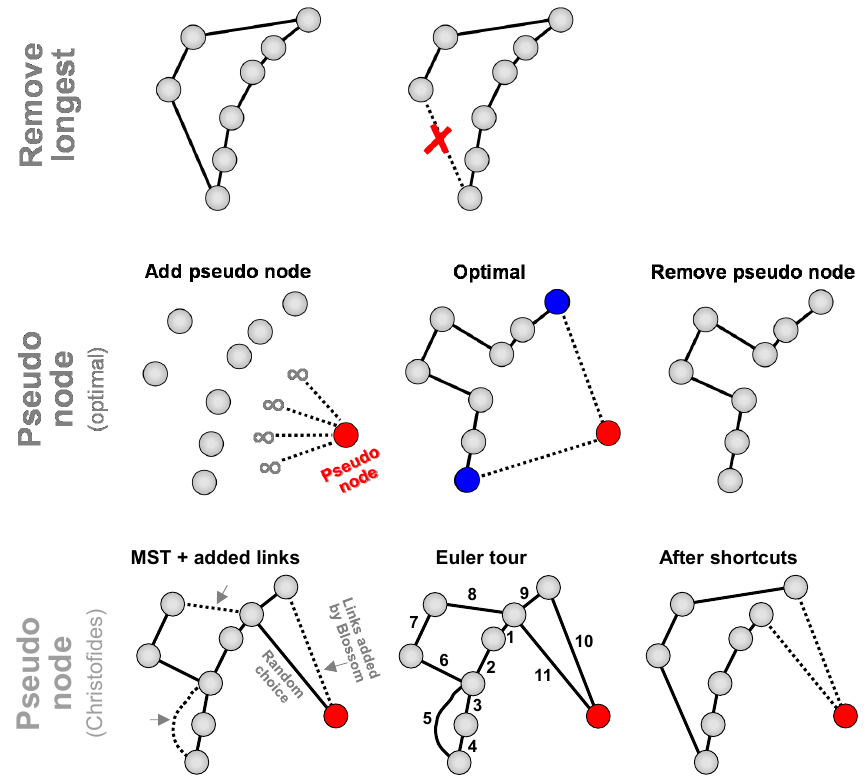
Figure 7. Two strategies for applying closed-loop algorithms for the open-loop cases. First strategy (top) simply removes the longest link, but this does not guarantee optimality even if the closed-loop solution is optimal. Second strategy adds pseudo node with equal distance to all other nodes. The consequence is that there are two long links connected to the pseudo node that can be omitted from the closed-loop solution. This does not affect the optimization at all due to the equal weights. The nodes linked to the pseudo node will become the start and end nodes of the open-loop